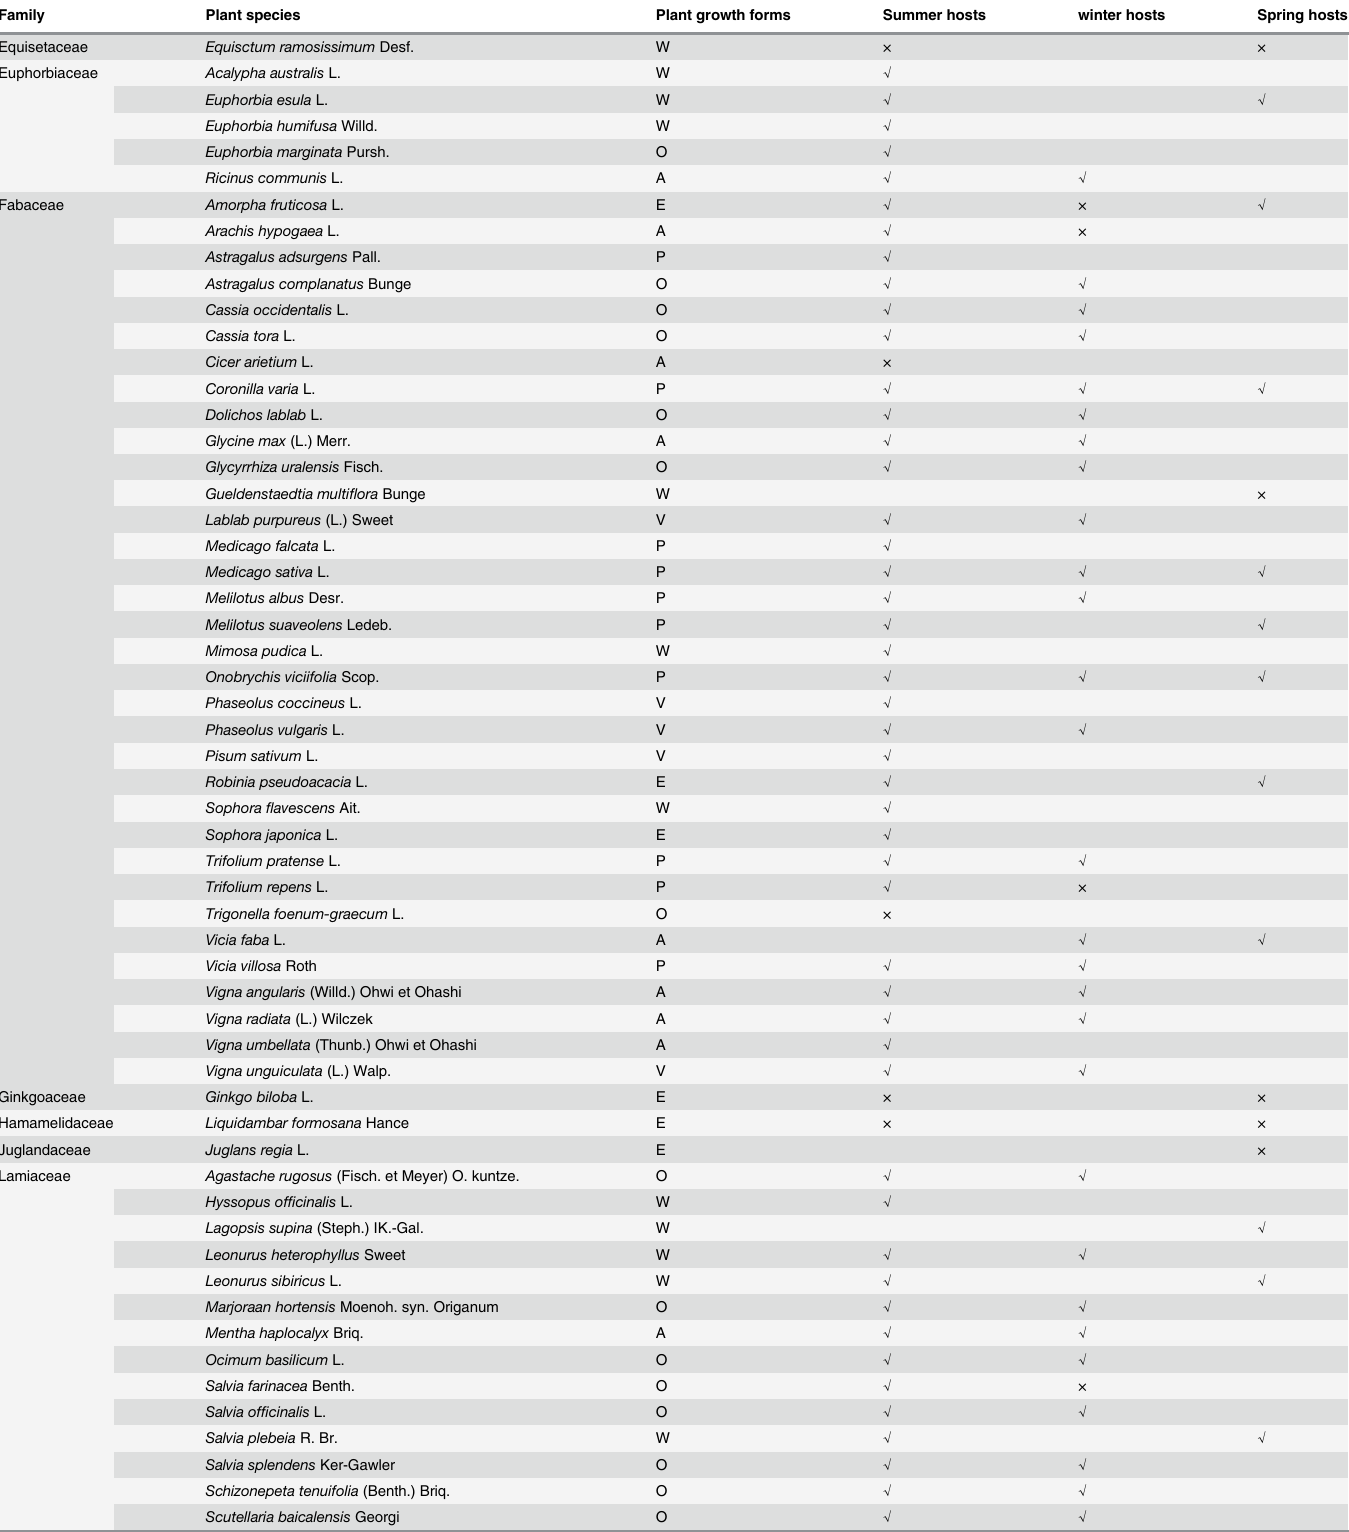
Ocimum basilicum L. O √ √ Salvia farinacea Benth. O √ × Salvia of fi cinalis L. O √ √ Salvia plebeia R. Br. W √ √ Salvia splendens Ker-Gawler O √ √ Schizonepeta tenuifolia (Benth.) Briq. O √ √ Scutellaria baicalensis Georgi O √